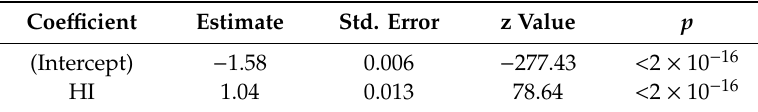
Table 4. Model coe ffi